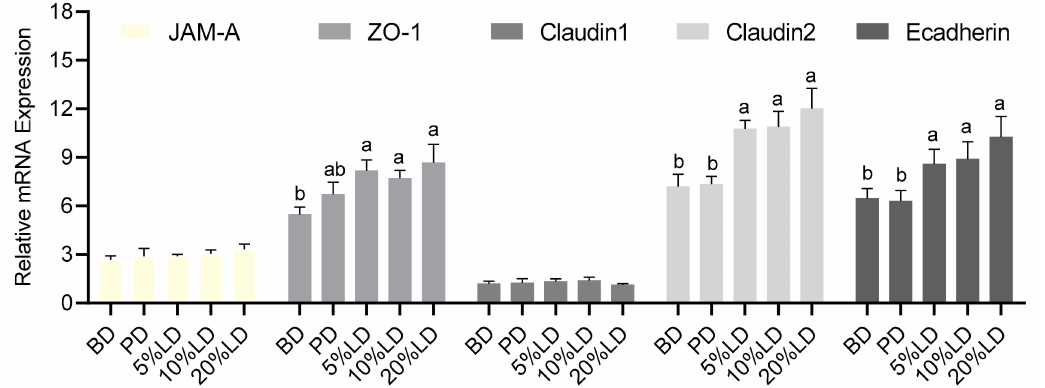
Figure 4. E ff ect of lentil supplementation on relative mRNA expression of colon apical junctional components. Values are mean ± SEM ( n = 12 / dietary group). Data for each gene were normalized to the expression of the housekeeping gene RPLP0. Bars not sharing a lower-case letter di ff er ( p < 0.05). BD = basal diet; PD = pectin diet; LD = lentil diet.